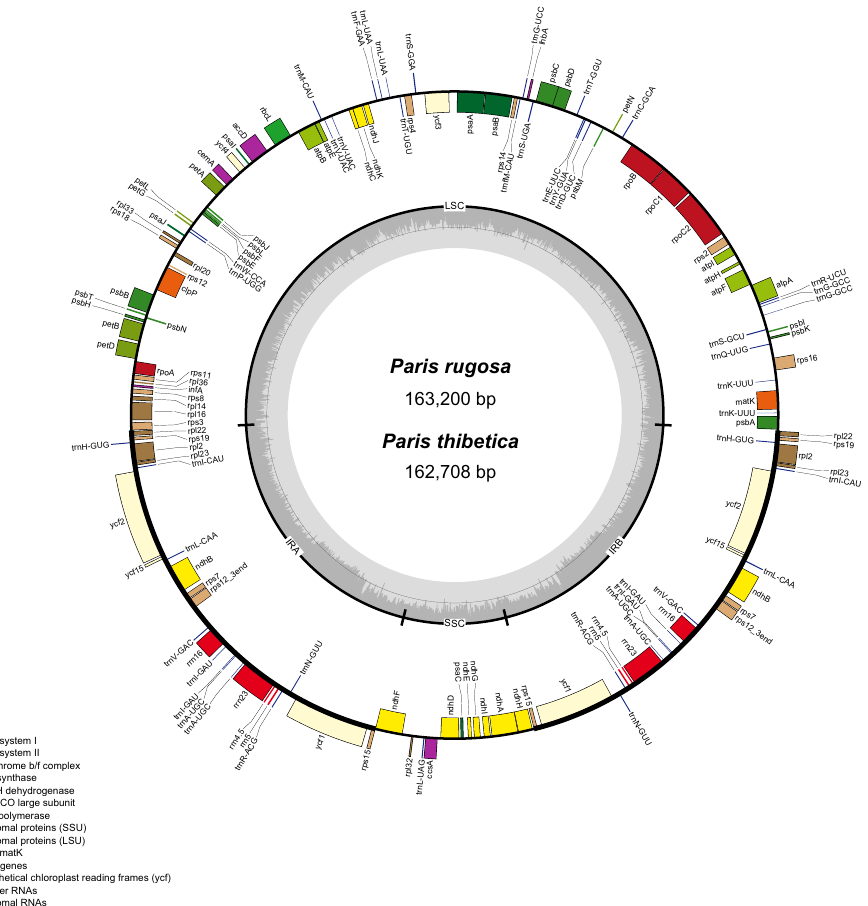
Figure 1. Gene map of Paris Chloroplast genome. The genes inside and outside of the circle are transcribed in the clockwise and counterclockwise directions, respectively. Genes belonging to different functional groups are shown in different colors. The thick lines indicate the extent of the inverted repeats (IRa and IRb) that separate the genomes into small single-copy (SSC) and large single-copy (LSC)